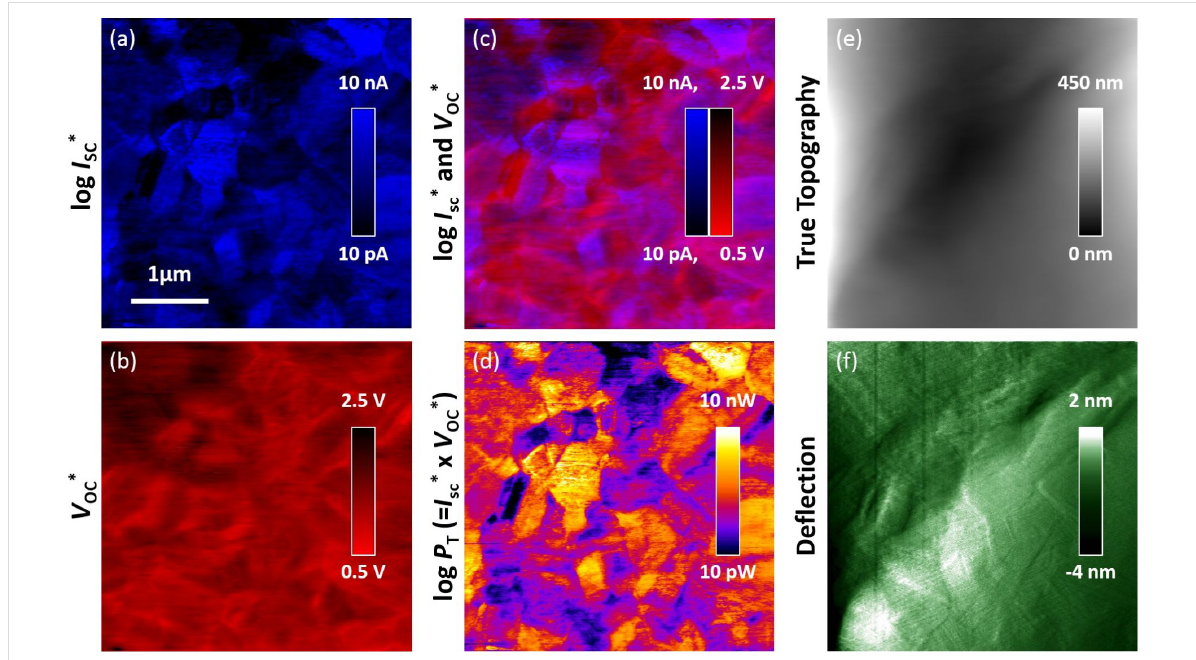
Figure 2: (a) Consecutively acquired I SC * (note the log scale) and (b) directly measured V OC * for a single ca. 4 × 4 µm area. (c) A simple overlay of these distinctly colored images is displayed, demonstrating their sometimes complementary and otherwise uncorrelated behavior. The product of I SC * and V OC * is shown in (d) indicative of the theoretical power ( P T* , log scale). (e) The simultaneously acquired true surface topography and (f) deflec- tion data (essentially an edge-filtered height image to identify any topographic steps or other microstructural boundaries) reveal little correlation with the photovoltaic